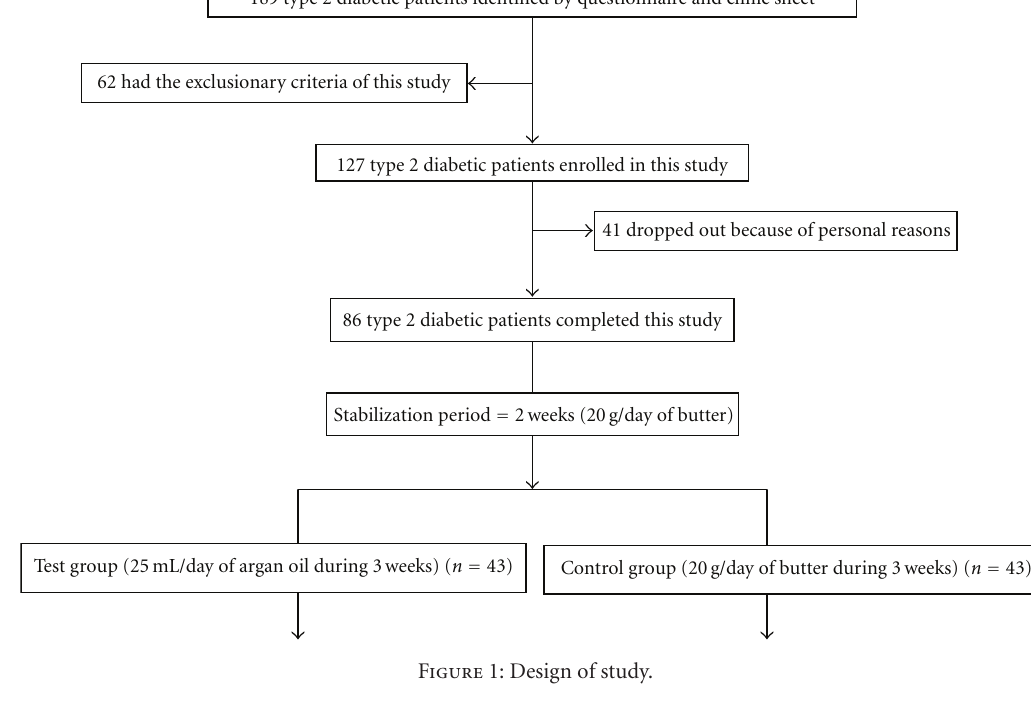
Figure 1: Design of